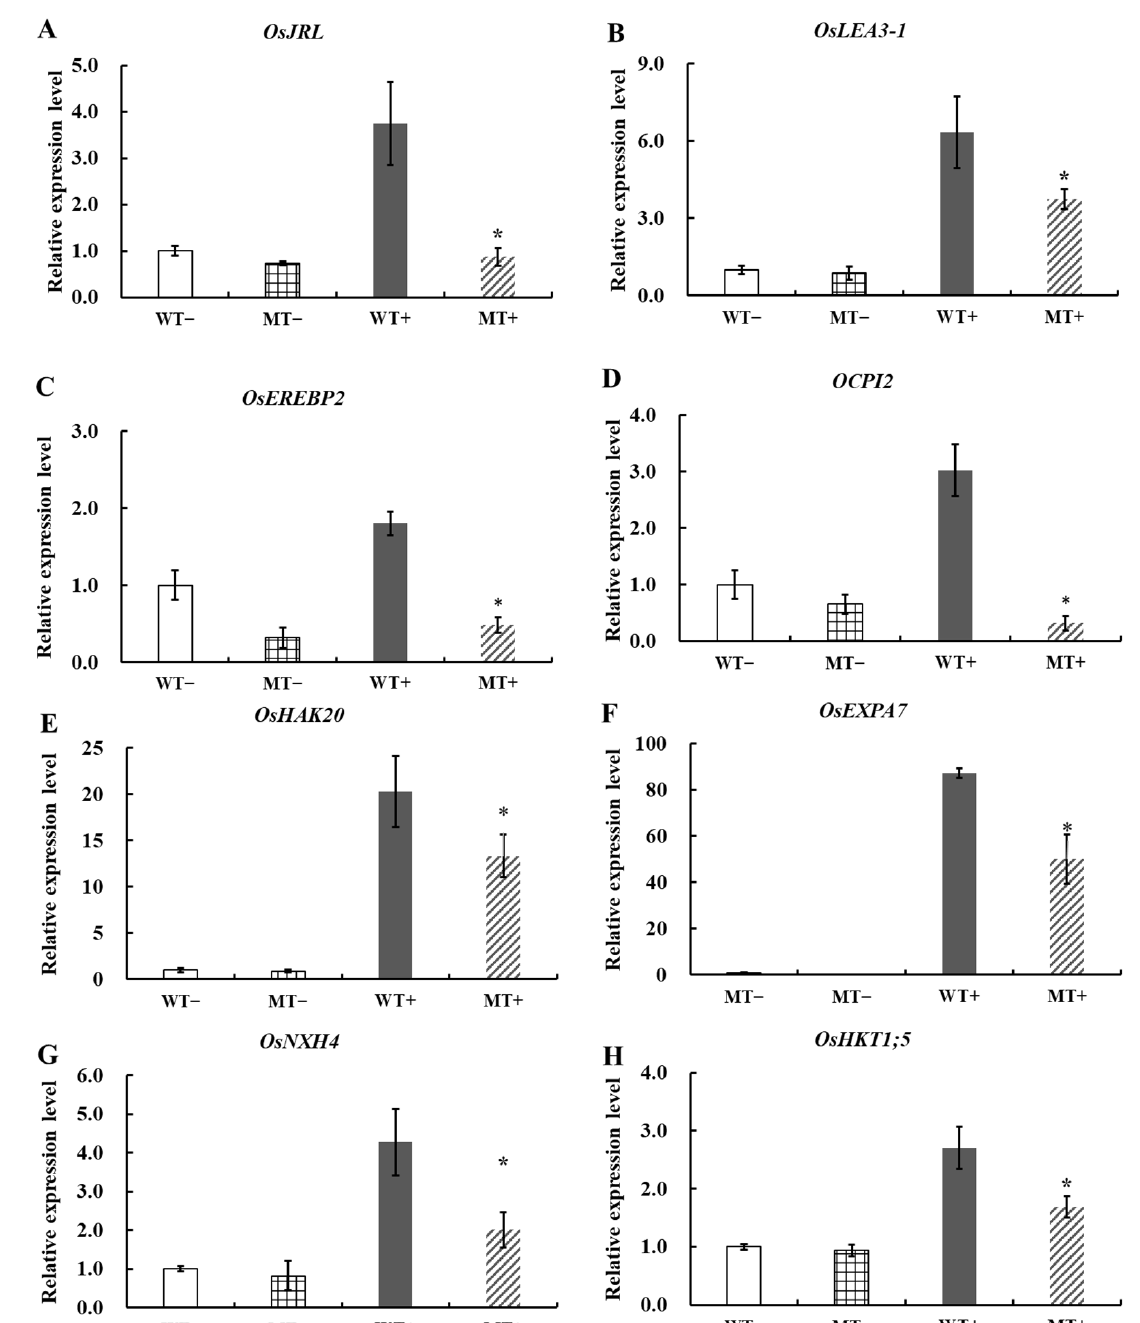
Figure 7. The relative expression level of candidate genes regulated by OsWRKY54 under control and high salinity conditions. OsJRL ( A ), OsLEA3-1 ( B ), OsEREBP2 ( C ) , OCPI2 ( D ) , OsHAK20 ( E ), OsEXPA7 ( F ), OsNXH4 ( G ), OsHKT1;5 ( H ). WT − and MT − represent the wild-type (WT) and the OsWRKY54 knockout mutant (MT) under control conditions, respectively. WT+ and MT+ represent the wild-type (WT) and the OsWRKY54 knockout mutant (MT) treated with 100 mM NaCl for 12 h, respectively. The data indicate the means ± SD (n = 4), * p < 0.05. 2.8. OsHKT1;5 Is a Direct Target of OsWRKY54 RNA-seq and qRT-PCR data showed that the expression level of OsHKT1;5 in the OsWRKY54 mutant roots is markedly lower than that in the wild-type roots under high- salinity conditions (Figure 7H; Table S1). A luciferase (LUC) assay in rice protoplasts